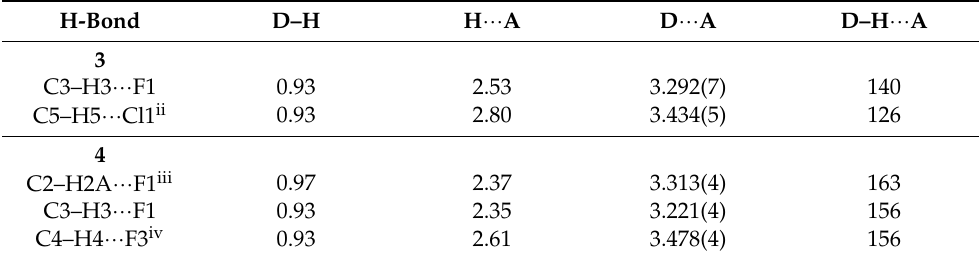
Table 3. Hydrogen bonding geometry (Å, °) for silver(I) complexes 3 and 4 .